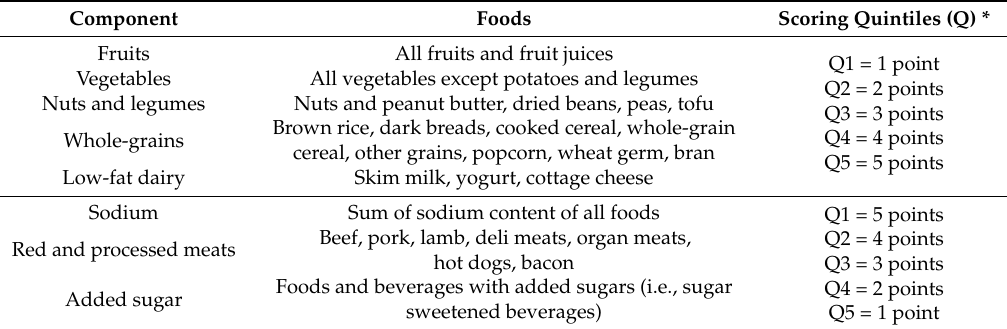
Table 3. Dietary Approaches to Stop Hypertension (DASH) dietary pattern scoring